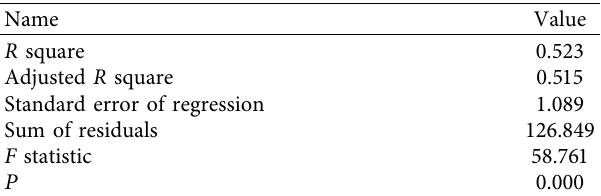
Table 7: Statistics of the linear model (mean absolute values of the acceleration slopes).